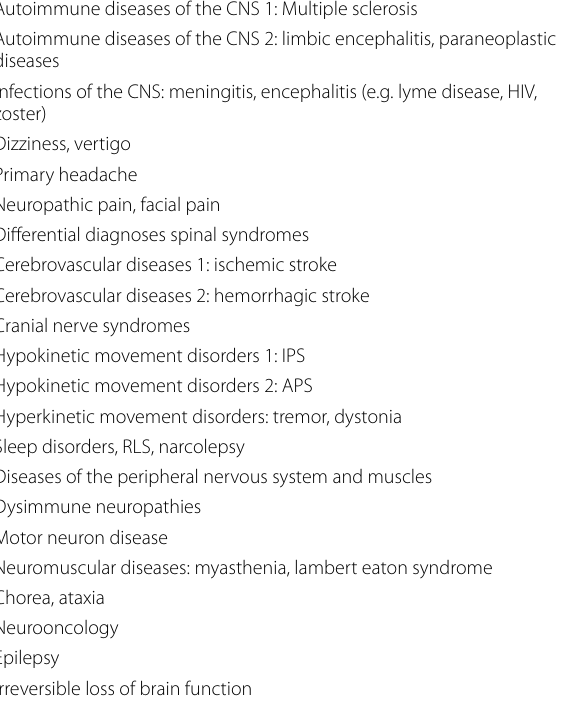
Introduction, Metabolic diseases of the CNS Autoimmune diseases of the CNS 1: Multiple sclerosis Autoimmune diseases of the CNS 2: limbic encephalitis, paraneoplastic diseases Infections of the CNS: meningitis, encephalitis (e.g. lyme disease, HIV, zoster) Dizziness,